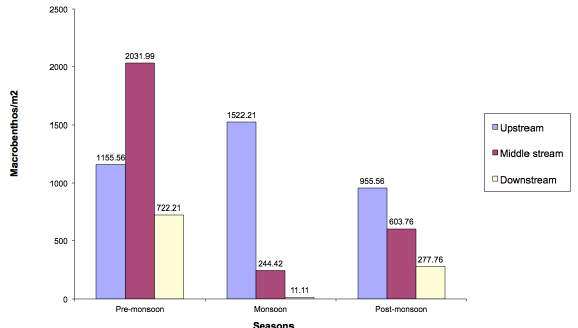
Figure 2. Seasonal variations of macrobenthic abundances in Ichamati at three different sites.